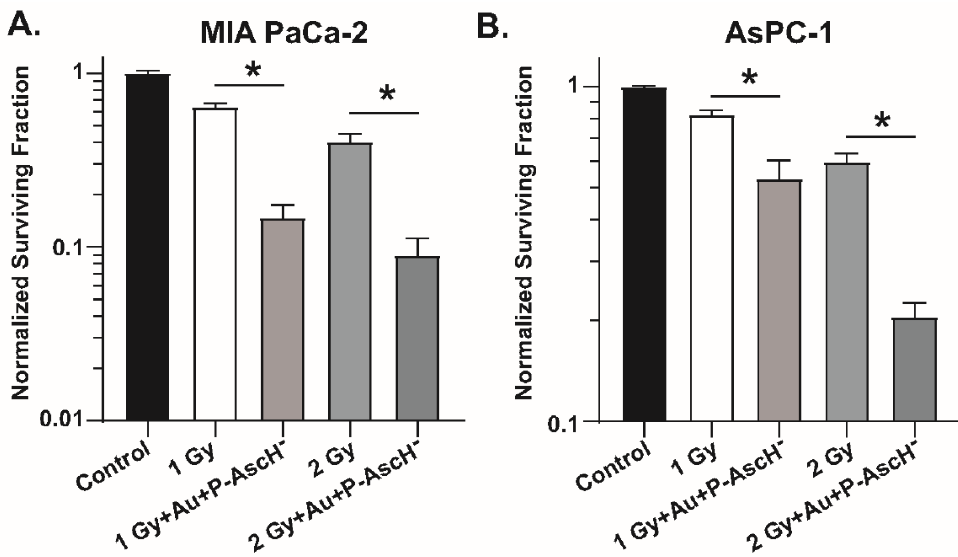
Figure 6. Au + P-AscH − radiosensitizes pancreatic cancer cell lines. ( A ) MIA PaCa-2 and ( B ) AsPC-1 cells were evaluated for clonogenic survival after treatment with either irradiation alone (1–2 Gy) or in combination with Au (500 nM, 24 h), P-AscH − (1–2 mM, 1 h), and irradiation (1–2 Gy). The combination of Auranofin and P-AscH − significantly reduced clonogenic cell survival of MIA PaCa-2 and AsPC-1 cells at both 1 and 2 Gy. Data represent normalized surviving fractions compared to controls ± SE (* p < 0.05; two-tailed unpaired Student’s t test). Reprinted/adapted with permission from Ref. 102. 2017, O’Leary, Elsevier. [102,103].